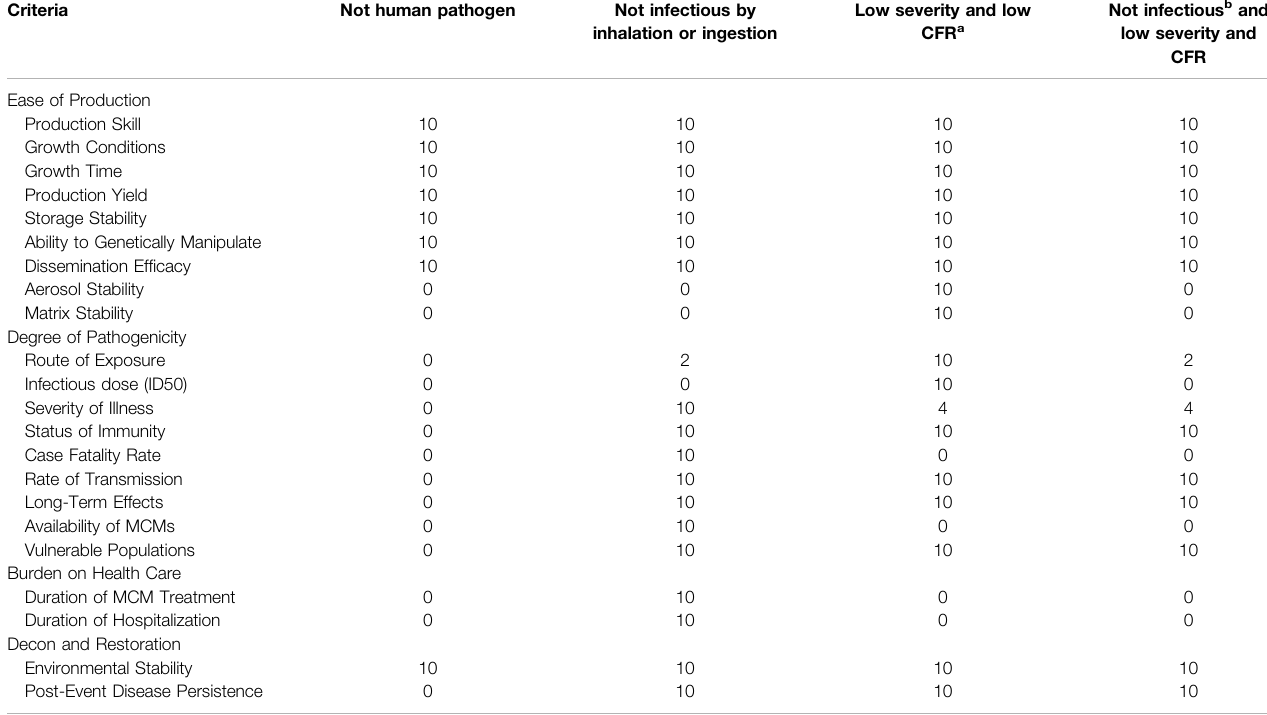
TABLE 3 | Scoring basis used to generate four simulated test agents.